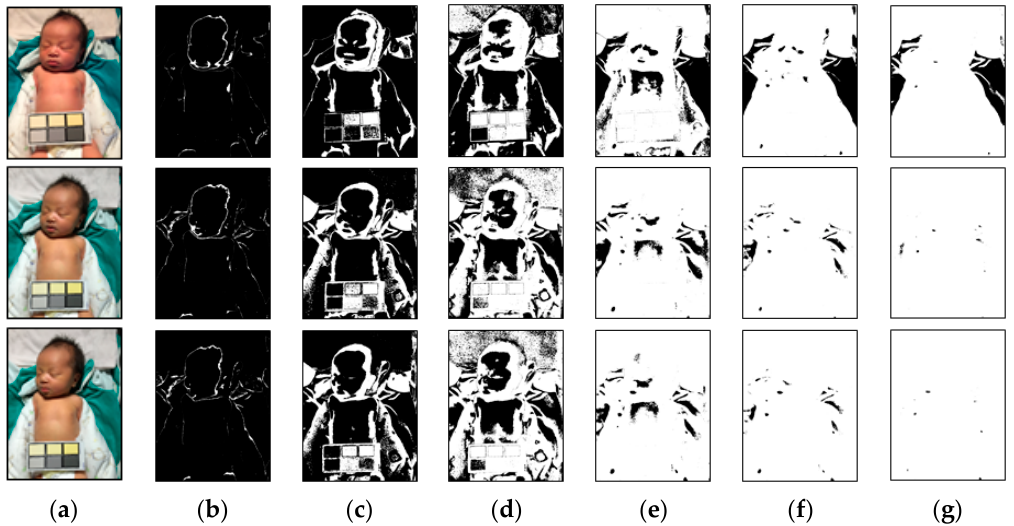
Figure 4. Results of the first step of processing of the original images. ( a ) Original images with various color temperatures (28, 48, and 65 K from top to bottom). ( b – g ) Results with W r values of 0.1, 0.5, 0.7, 1.0, 1.2, and 1.5. The white regions in the images are the white candidates.